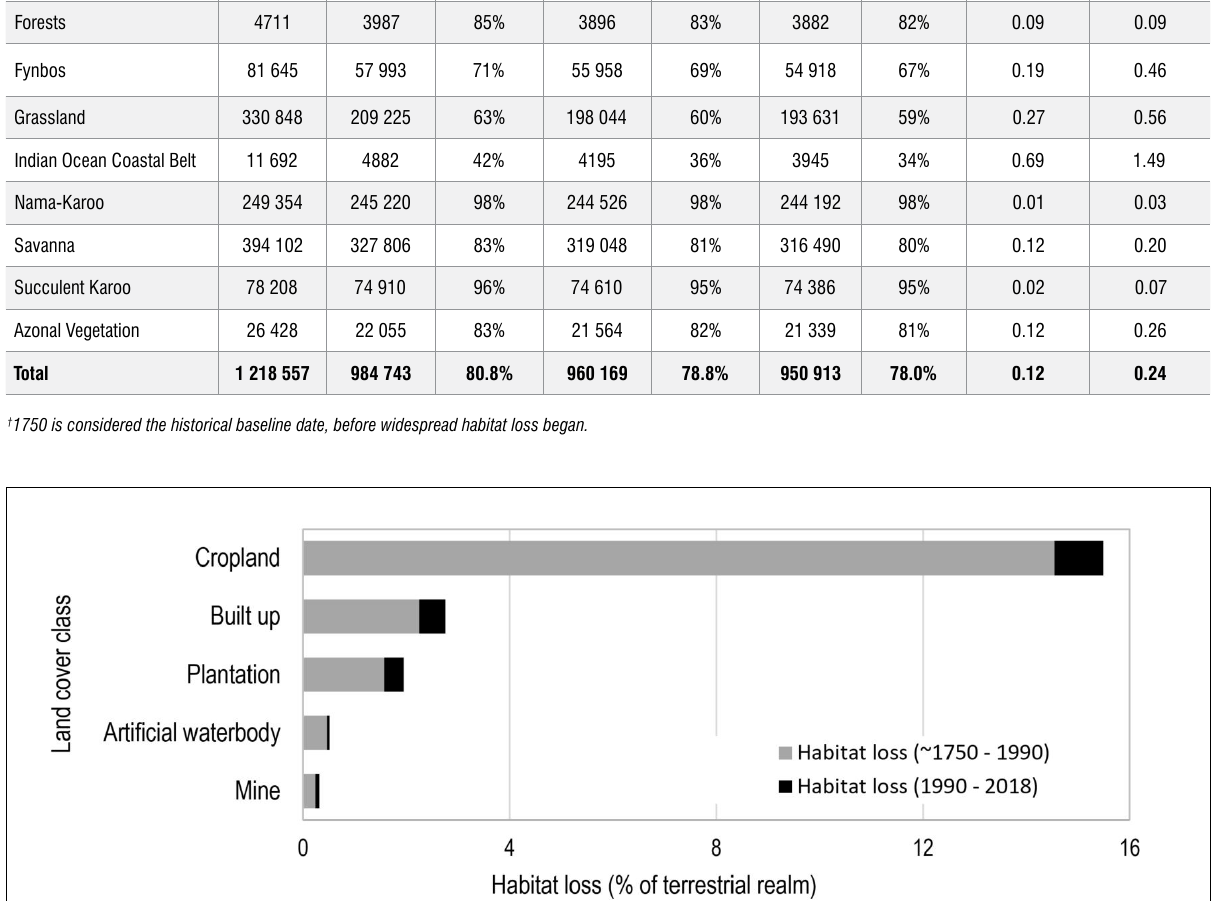
Figure 1: Habitat loss per major land-cover class (shown as a percentage of the terrestrial realm). Historical loss (between ~1750 and 1990) is shown in grey and recent loss (1990–2018) is shown in black. The clearing of natural habitat for the establishment of field and horticultural crops is the single largest historical driver of biodiversity loss in South